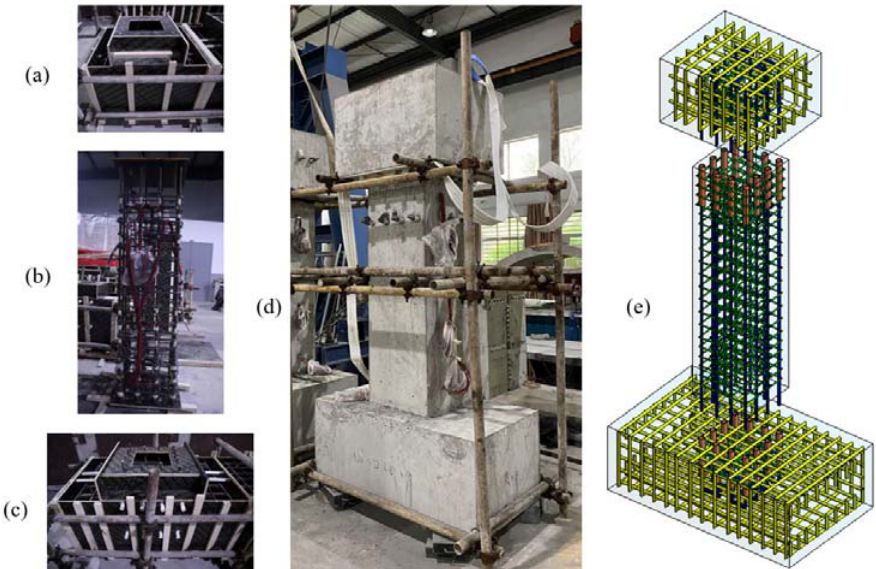
Figure 2. Construction of the precast column with grouted sleeve connections: ( a ) cap beam; ( b ) column; ( c ) footing; ( d ) assembling; ( e ) 3D model of the precast column.